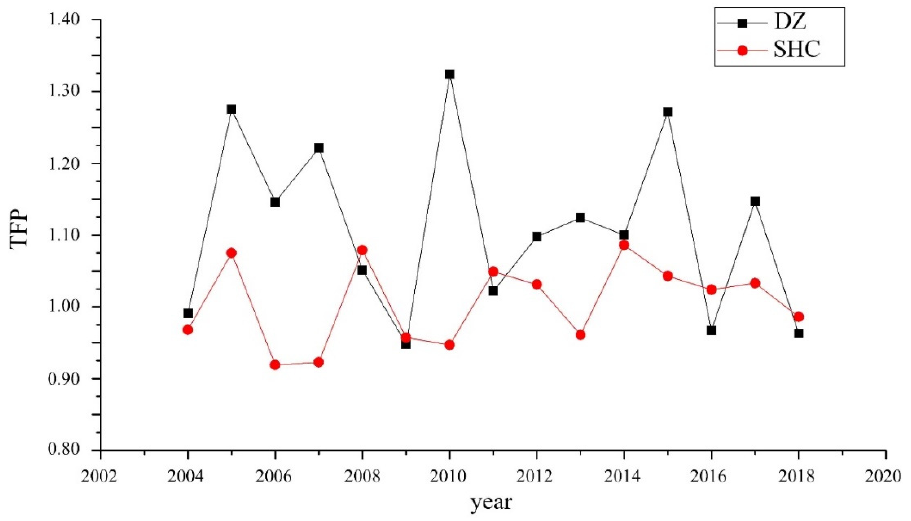
Figure 3. Changes in the TFP of the DZs and SHCs.